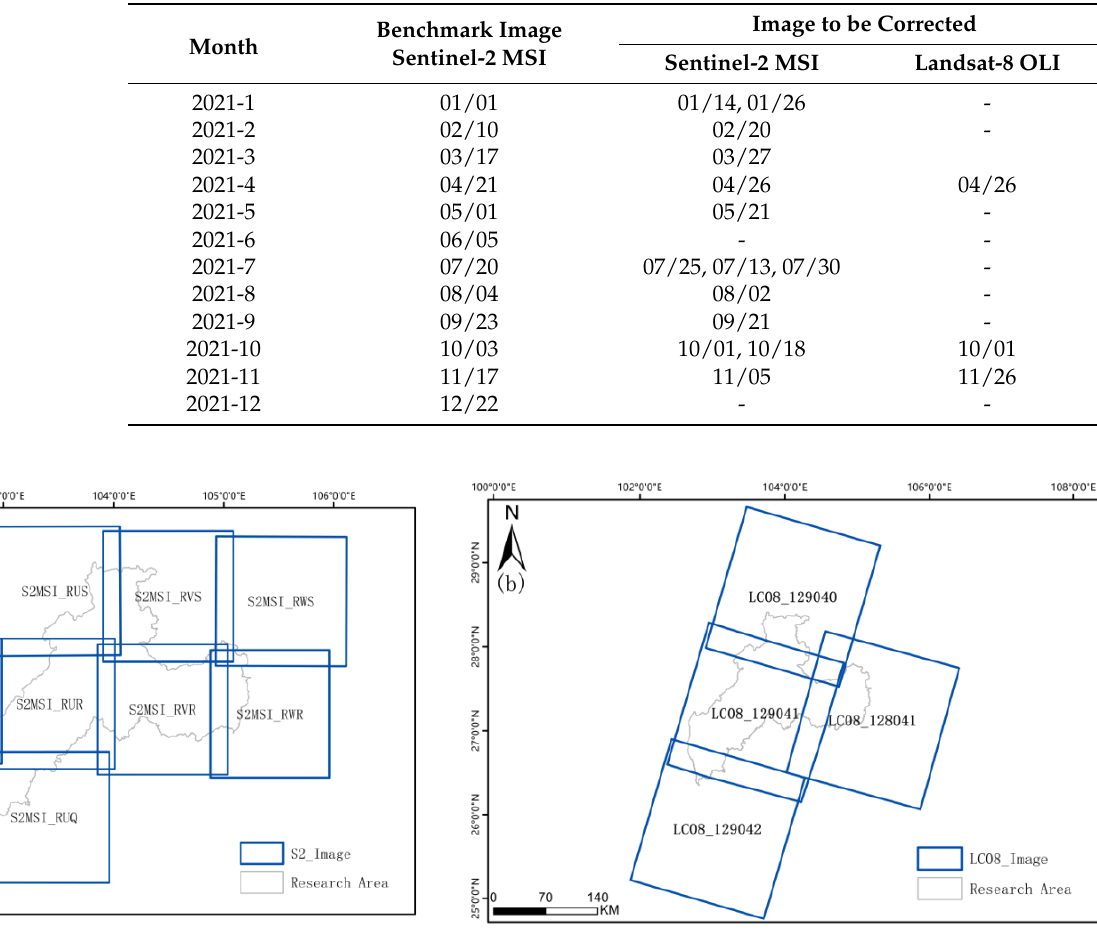
Figure 4. Image distribution required to fully cover Zhaotong City. ( a ) Sentinel-2 image distribution; ( b ) Landsat-8 OLI image distribution.